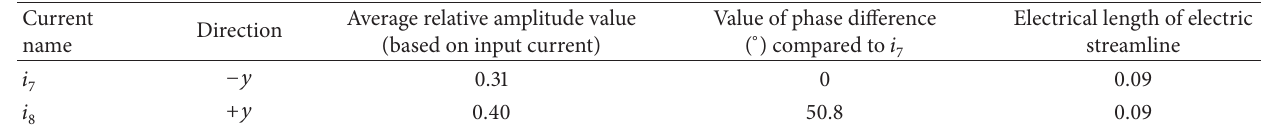
Table 2: Surface current ( 𝑖 7 ∼𝑖 8 ) at 1228 MHz.